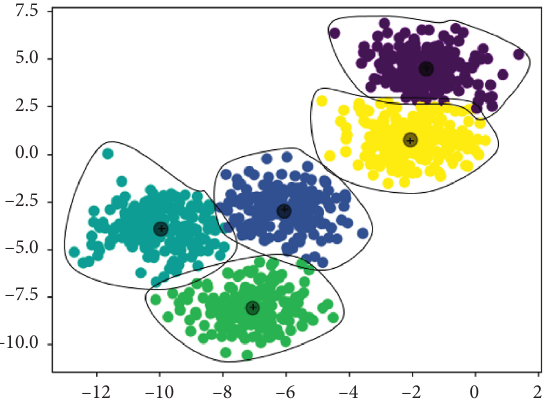
Figure 12: Cluster partitioning map. Table 4: Information of six data